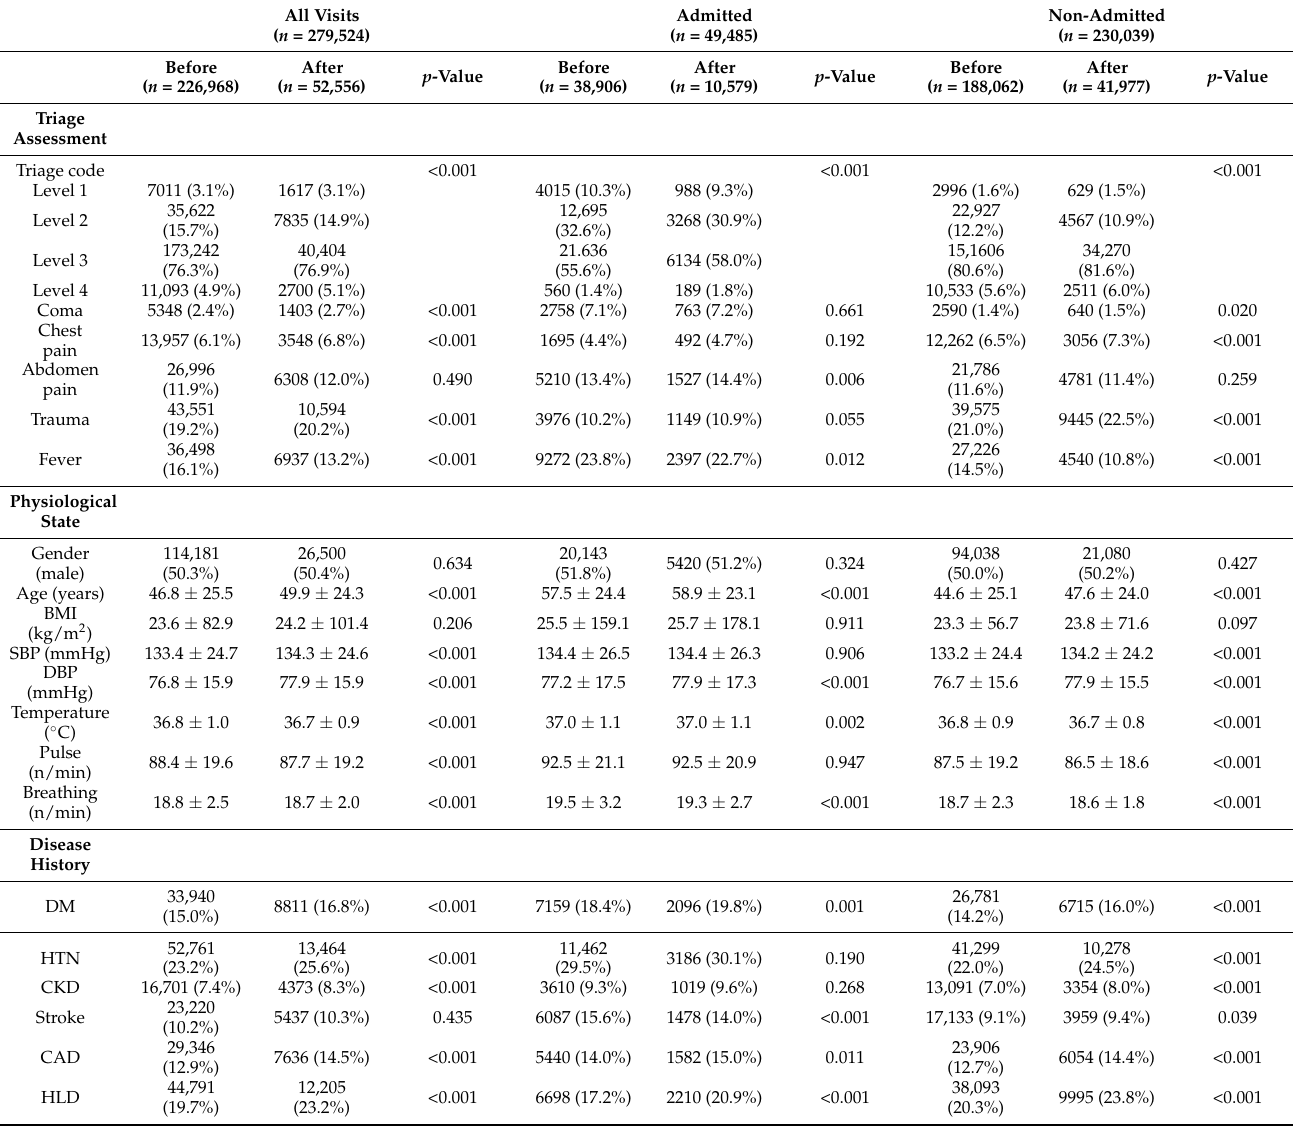
Table 2. Baseline characteristics before and after the start of the COVID-19 pandemic among admitted and non-admitted visits. All Visits ( n =